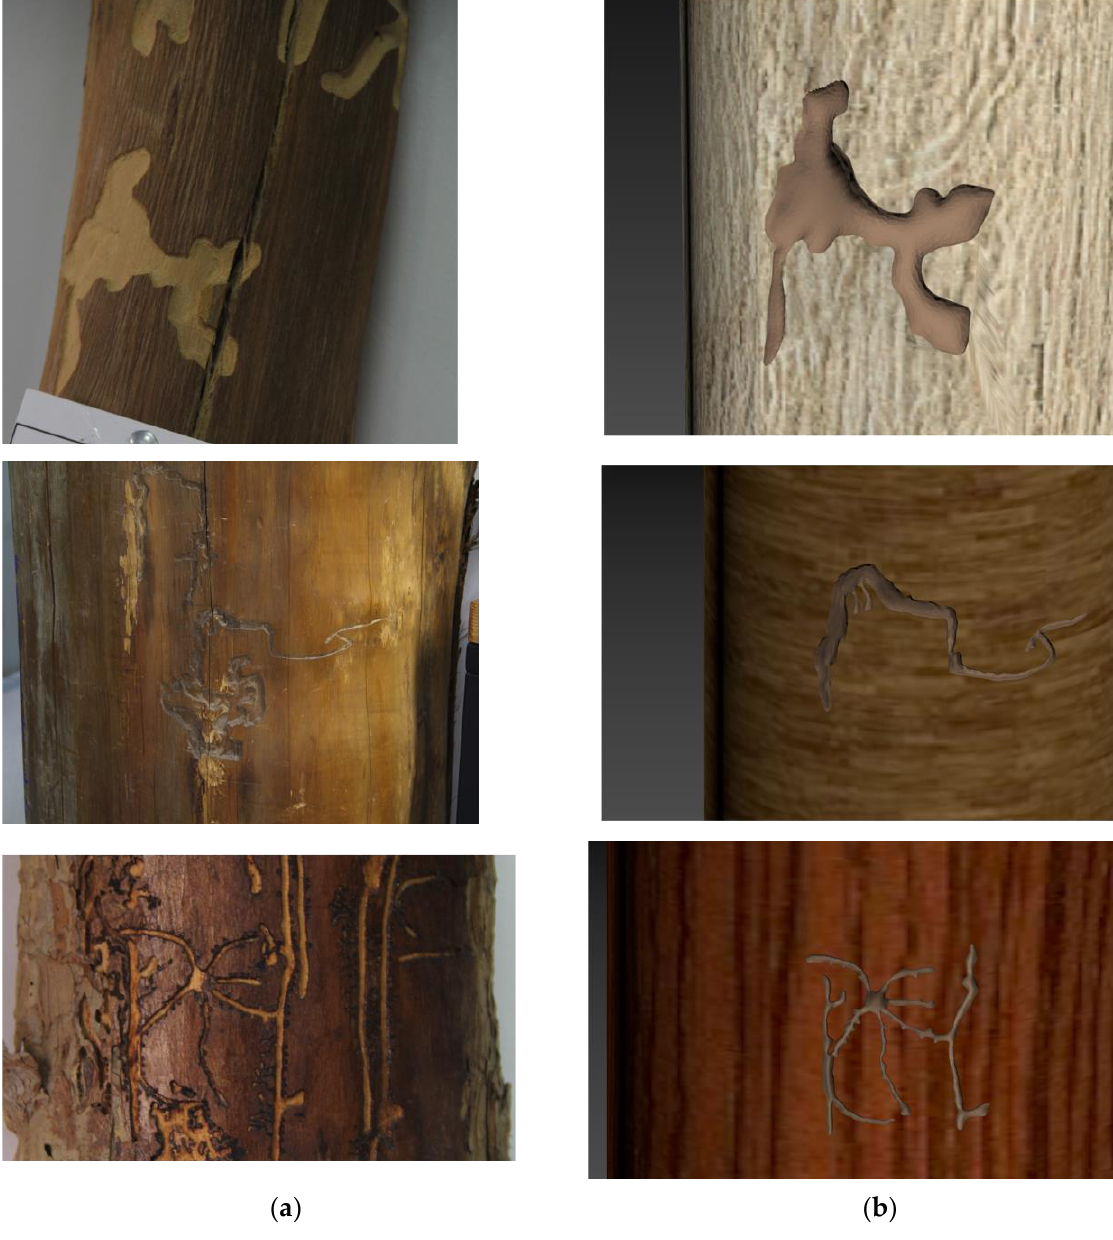
Figure 9. Visualization effect display column ( a ) is the real shot image; column ( b ) is the synthetic effect.